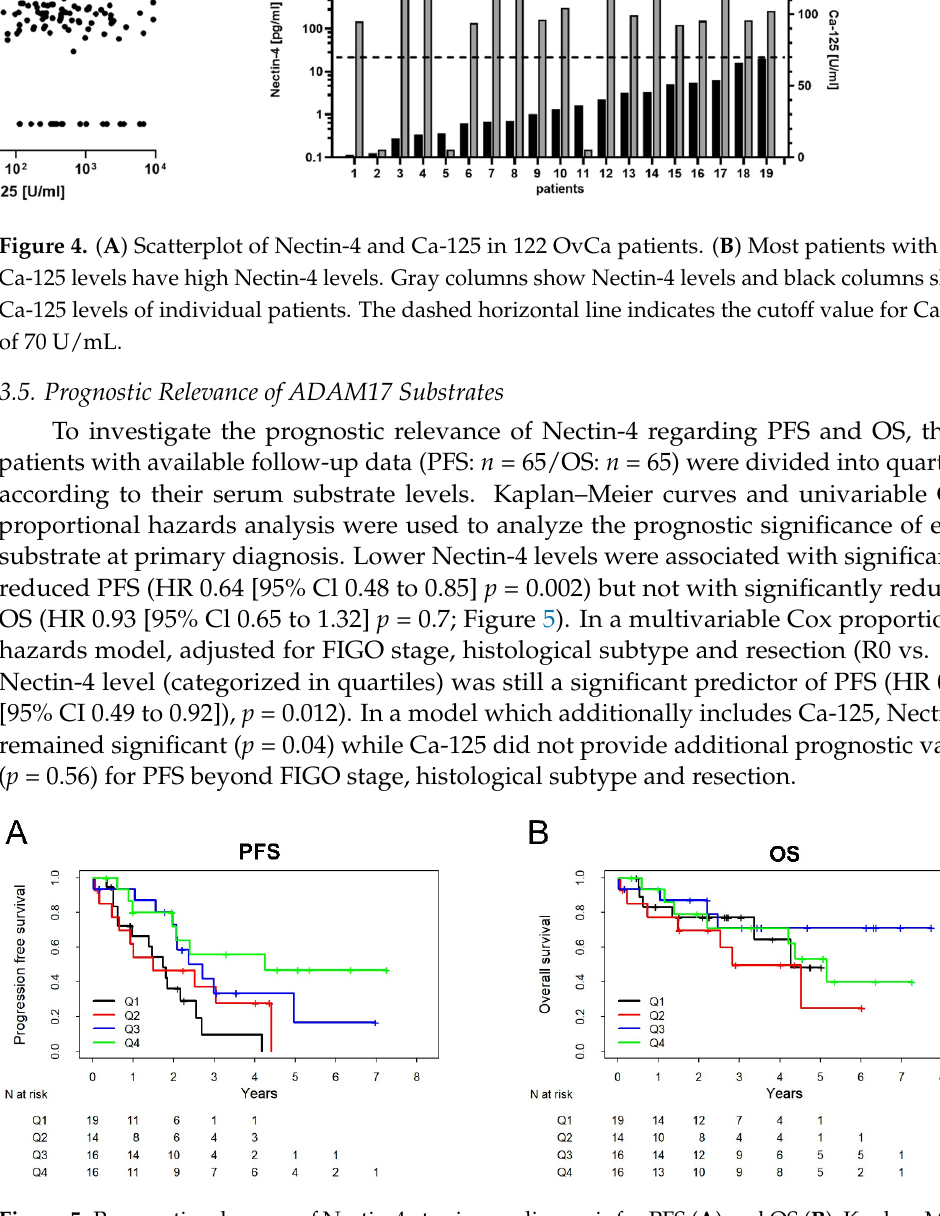
Figure 5. Prognostic relevance of Nectin ‐ 4 at primary diagnosis for PFS ( A ) and OS ( B ). Kaplan– Meier curves for patients with Nectin ‐ 4 levels categorized in quartiles